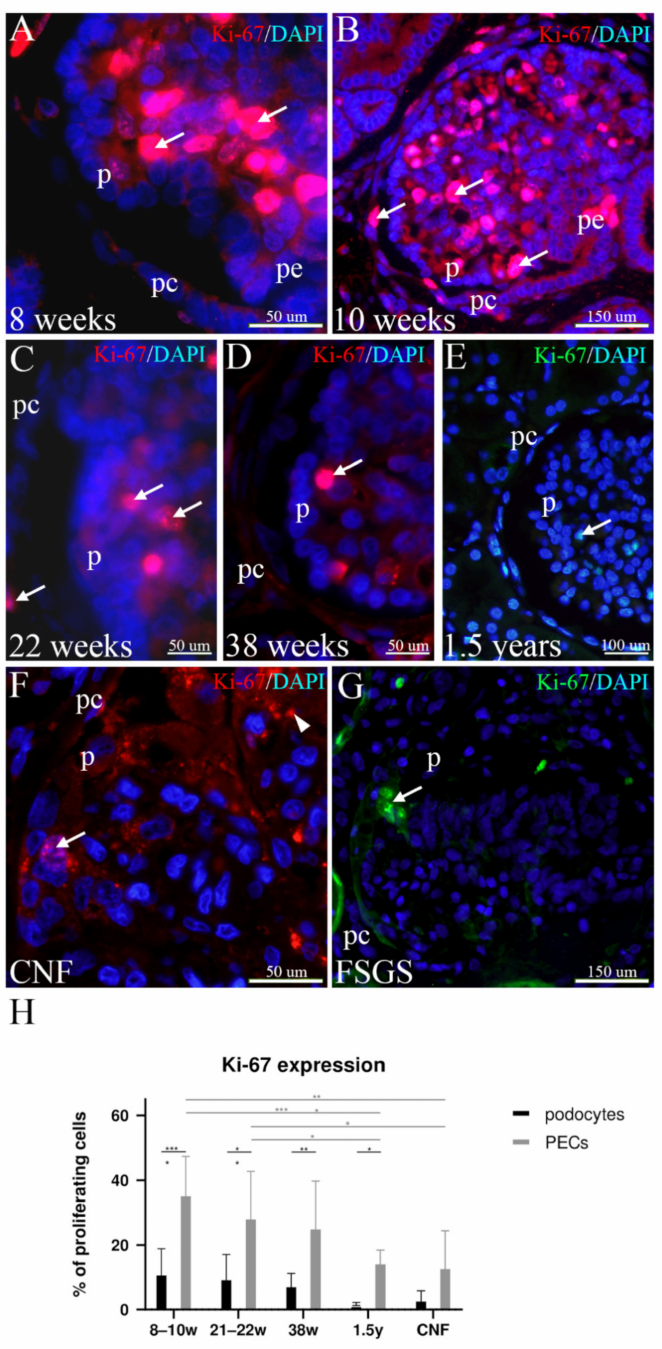
Figure 2. Proliferating (Ki-67-positive) podocytes and PECs during human kidney development, in postnatal, healthy, and pathologically changed kidneys (CNF, FSGS); podocytes (p), PECs (pc), peripolar cells (pe). ( A – D ) Normal developing kidneys; Ki-67-positive cells (arrows) predominate in the glomerular bulk in the earlier stages and characterize PECs, podocytes, and peripolar cells. ( E ) Postnatal healthy kidneys; a reduced number of Ki-67-positive cells (arrow) is observed in the podocytes and PECs. ( F ) CNF kidneys; proliferating cells are seen only occasionally (arrow) and an accumulation of unspecific staining can be observed in disintegrating cells (arrowhead). ( G ) FSGS kidneys; groups of proliferating cells (arrow) connect PECs and podocytes. ( H ) Graph showing percentages of Ki-67-positive cells (podocytes and PECs) during development, postnatally, and in CNF and FSGS samples. Error bars show SD. * p < 0.05; ** p < 0.01; *** p <